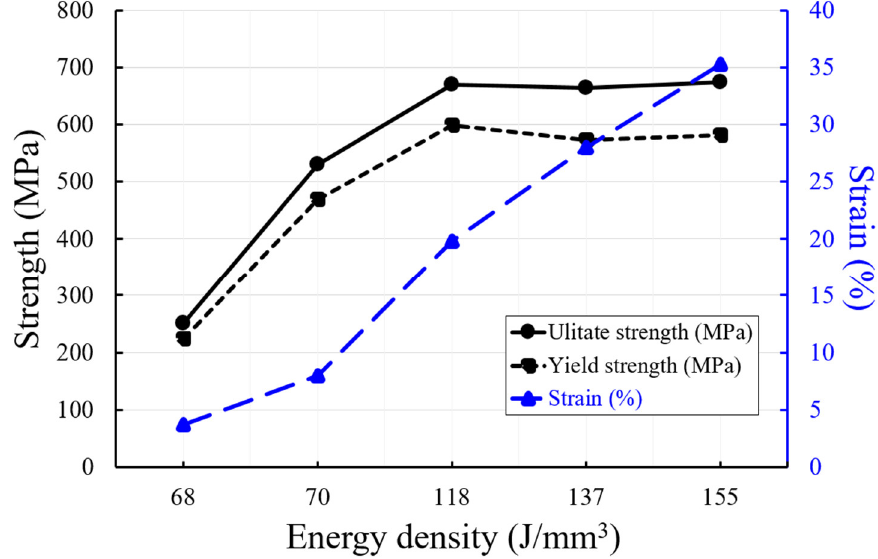
Figure 10. The ultimate strength, yield strength, and elongation variation curves according to the energy density (J/mm 3 ).